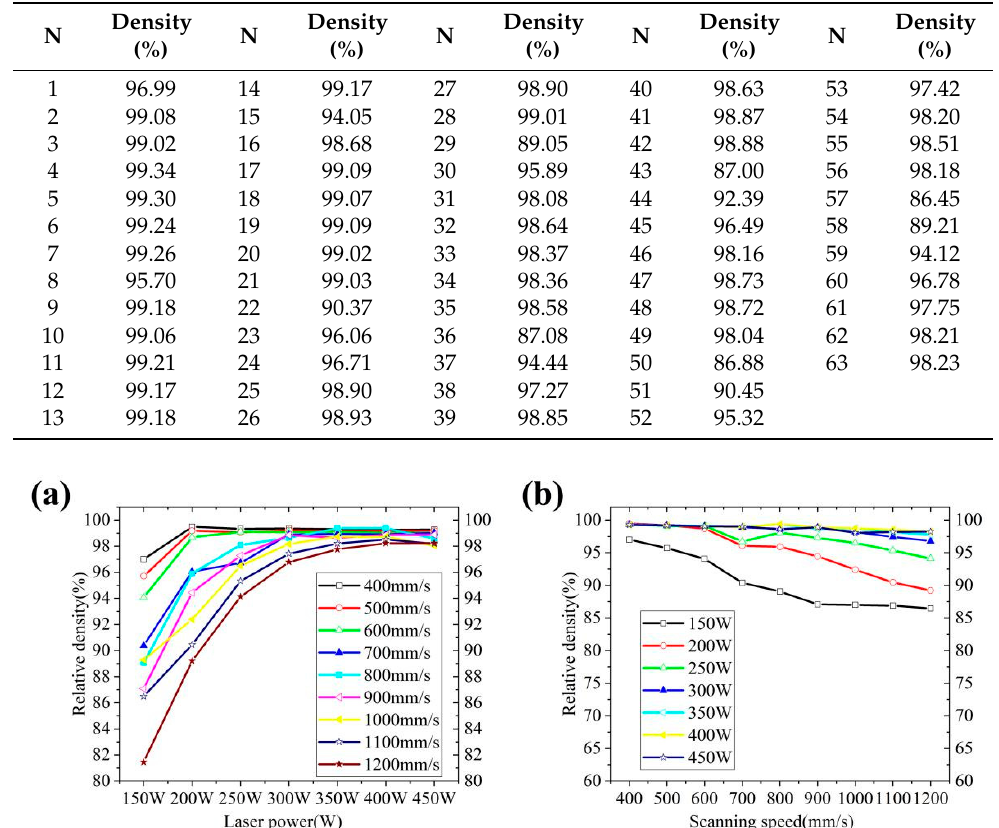
Table 7. Test results of density in the first orthogonal test.